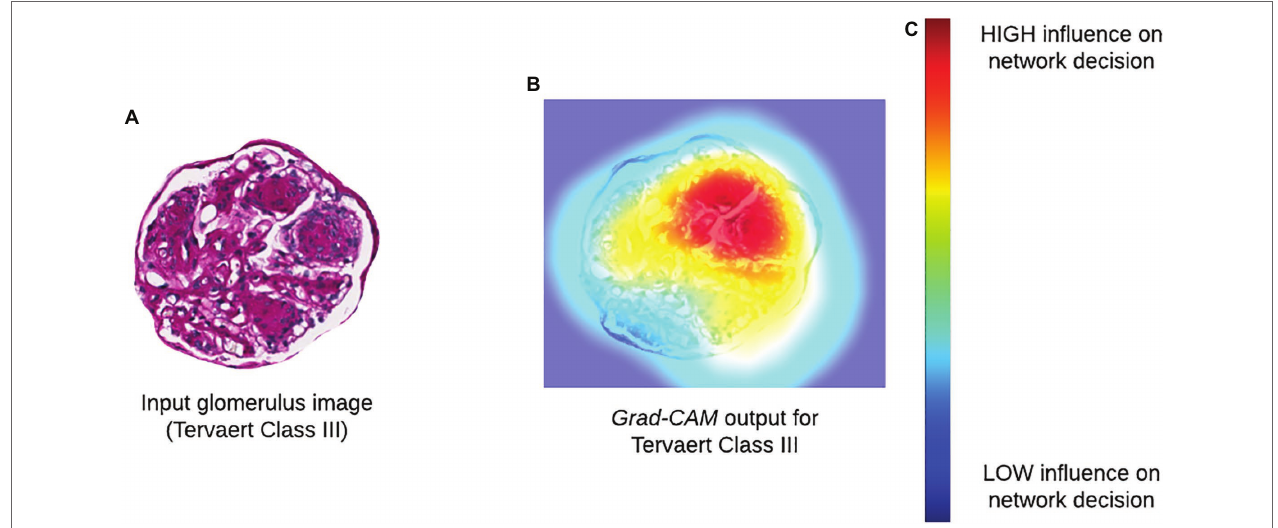
FIGURE 3 | Incorporating biological interpretability. (A) Input glomerulus image to a CNN trained to predict severity of progression of diabetic nephropathy according to Tervaert criteria. (B) Grad-CAM output indicating relative influence of pixels in each region within the original image. (C) Colormap for Grad-CAM heatmap illustrating degree of influence of a particular region on the decision of a